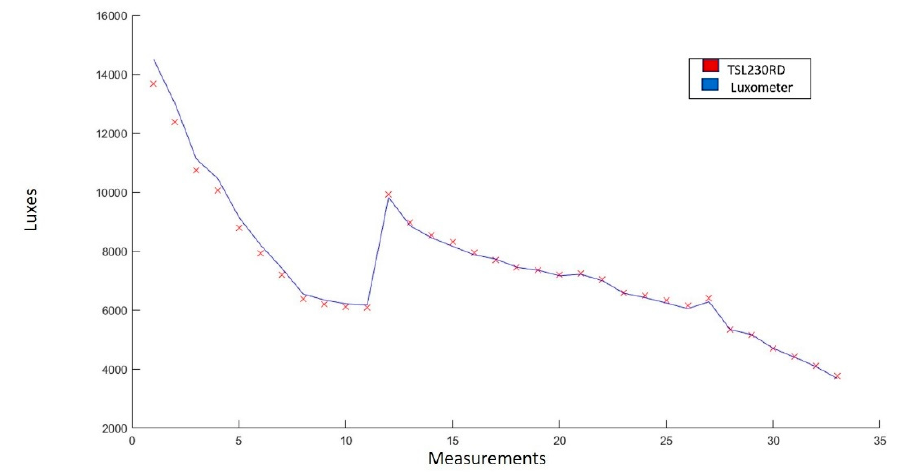
Figure 12. Comparison of the measurements made by the lux meter (blue line) and by the TSL230 sensor (red line). The experimentation range was 3600–15,000 luxes. In total, 33 measurements were made.